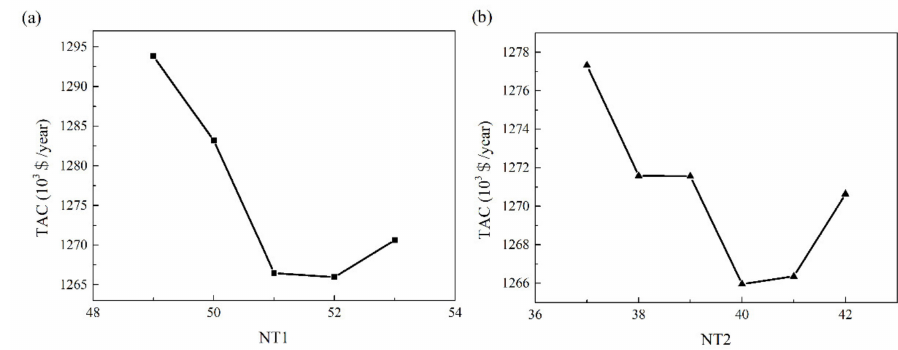
Figure 5. ( a ) Effect of NT1 on the TAC ( b ) effect of NT2 on the TAC.